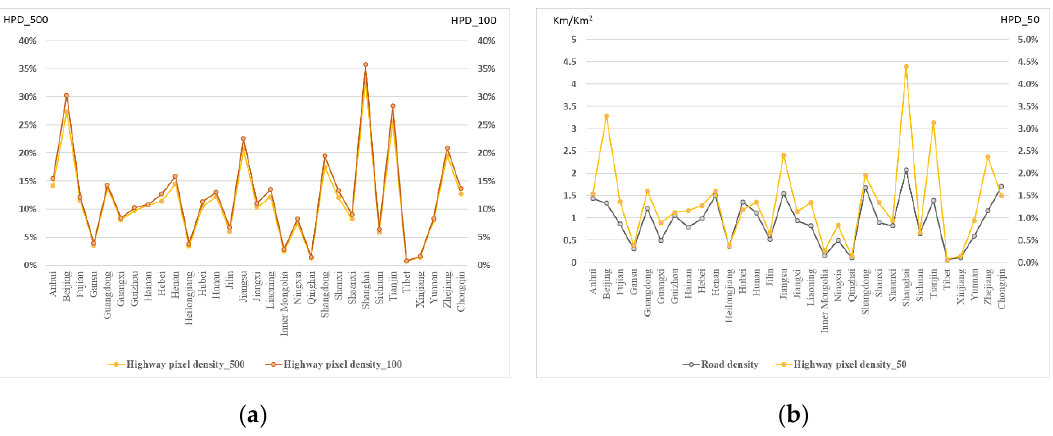
Figure 6. Highway pixel density: ( a ) The original-size HPD and HPD_100; ( b ) The road density and HPD_50.